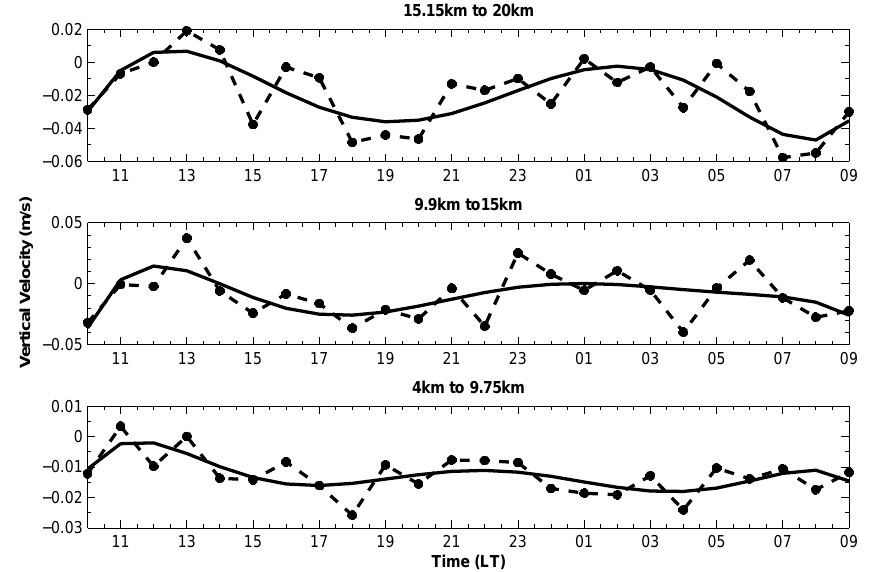
Fig. 3. Diurnal variation of mean vertical velocity in three different height blocks.